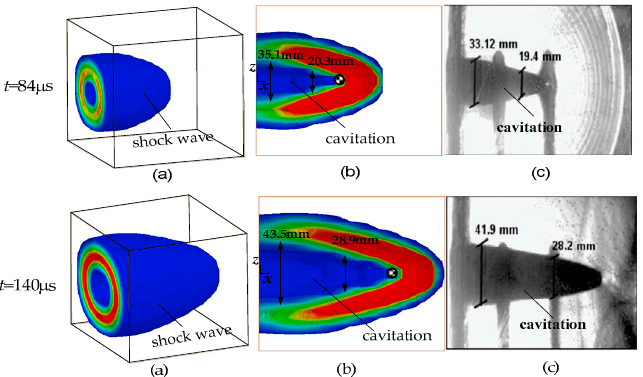
Figure 3. ( a ) Pressure nephogram of the shock wave in water. ( b ) Sectional view on the xoz plane. ( c ) Picture captured by a high-speed camera in Varas test [9].